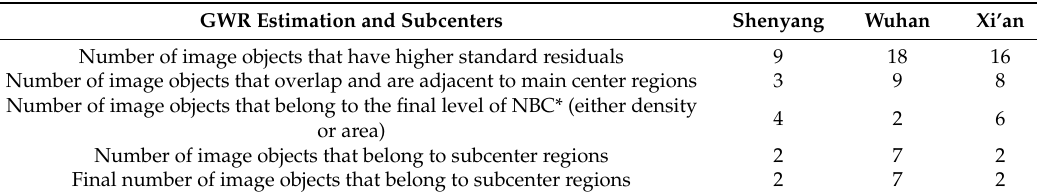
Table 3. Results for